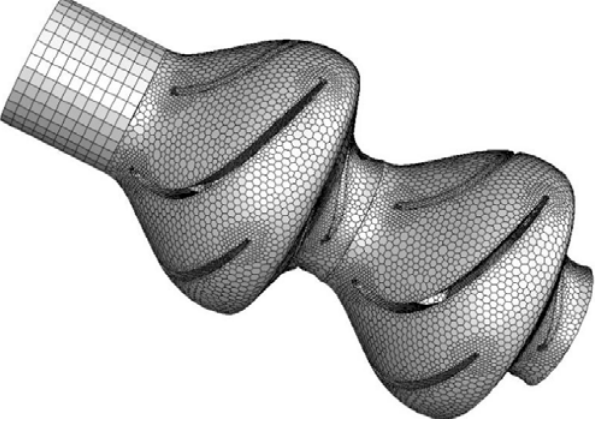
Figure 4. Mesh of two-stage centrifugal pump.